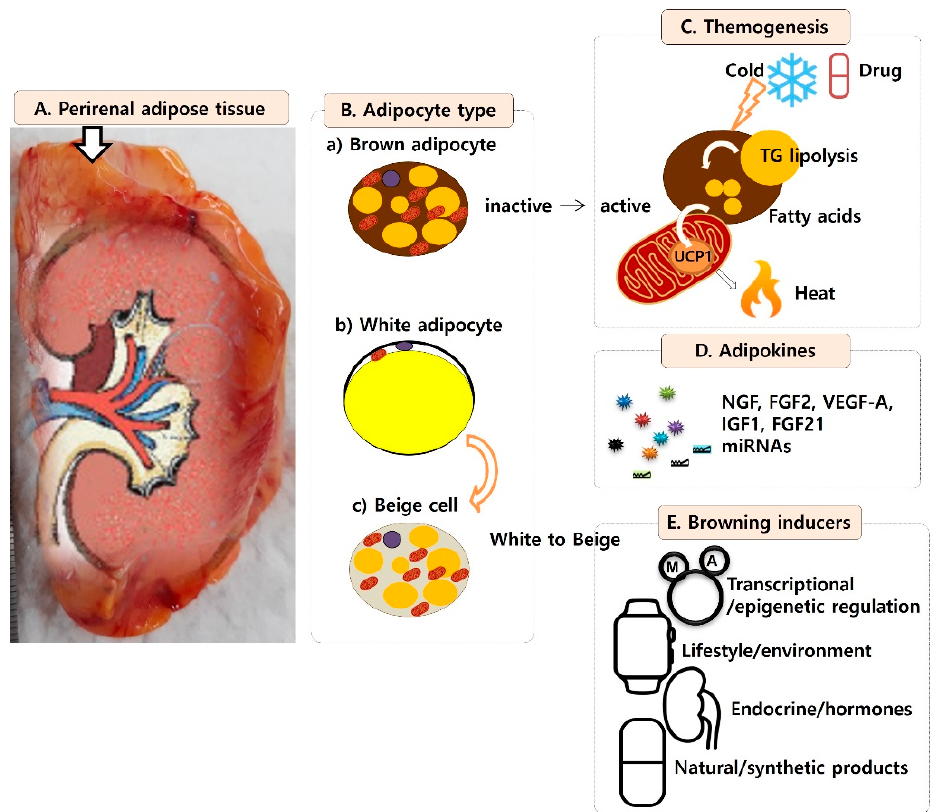
Figure 1. Characterization of perirenal adipose tissue. ( A ) Anatomic location of perirenal adipose tissue, ( B ) Perirenal adipose tissue composing adipose cell types, ( C ) Themogenesis of brown adipocyte for calorie burning, ( D ) Adipokines, secreted by brown, white and beige adipocytes, and ( E ) Browning inducers for white adipocyte transformation into beige cell.